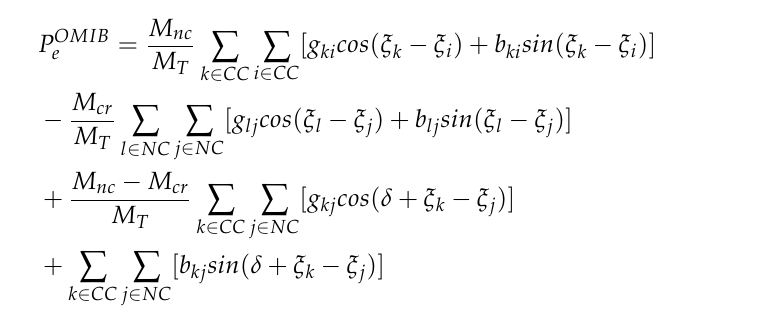
Figure 7. Representation of a synchronous generator by a constant voltage behind transient